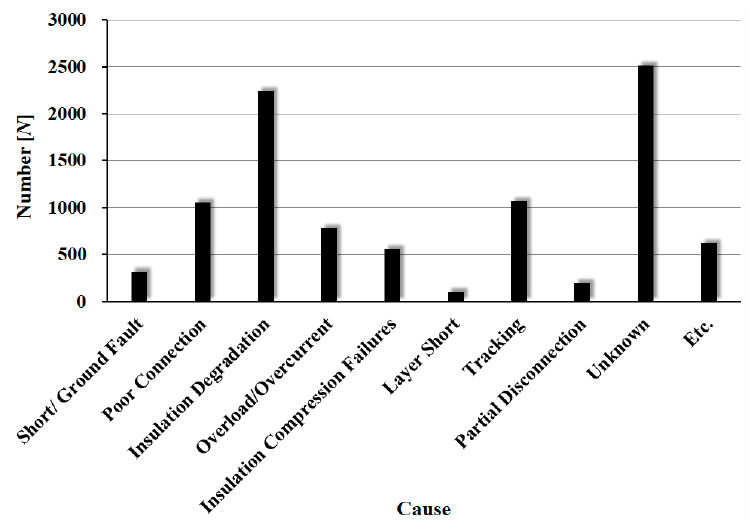
Figure 1. Causes of electrical fires in South Korea in 2019. (Data from Korea National Fire Data System).